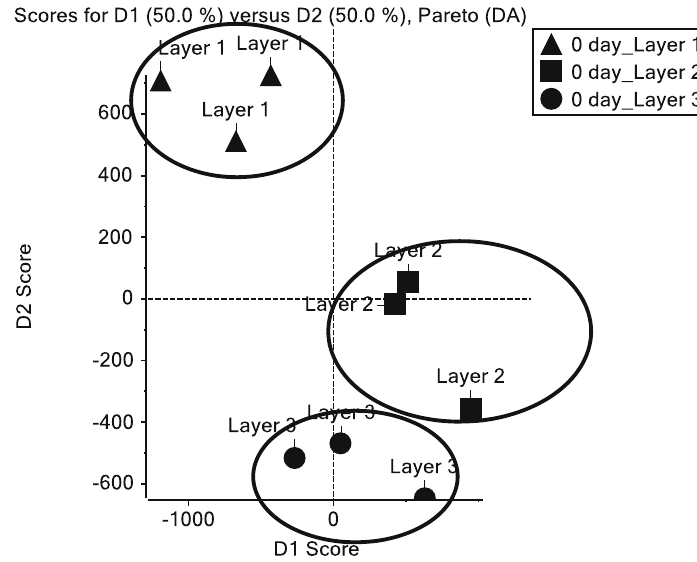
Figure 2: PCA scores plots of CC - DHs in three outer leaves of fresh